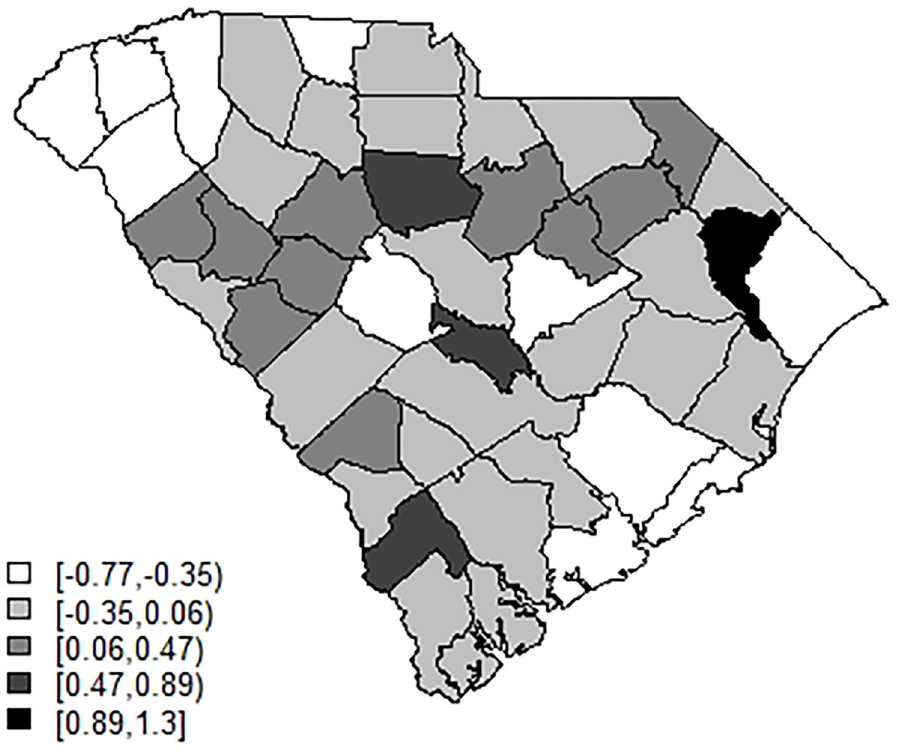
Fig 2. Posterior mean uncorrelated effect for model